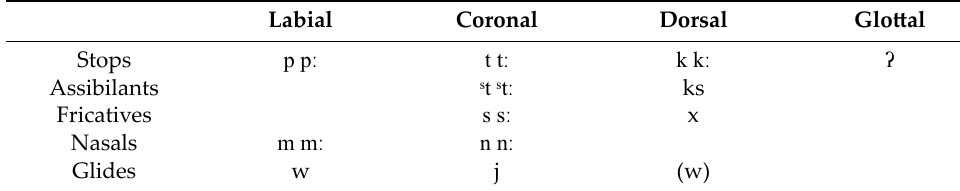
Table 4. Blackfoot phonemic vowel inventory (Weber 2020). Front Central Back High i iː o oː Mid